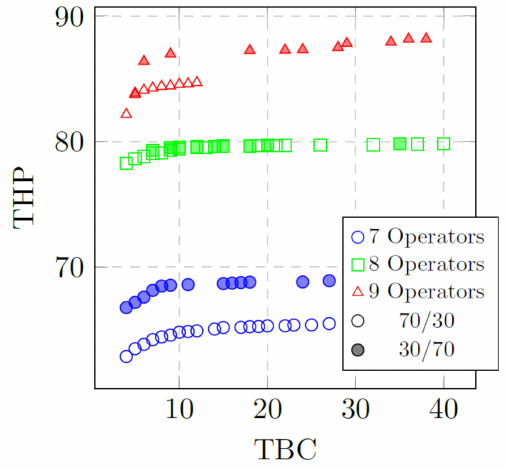
Figure 6. Objective space of non-dominated solutions.